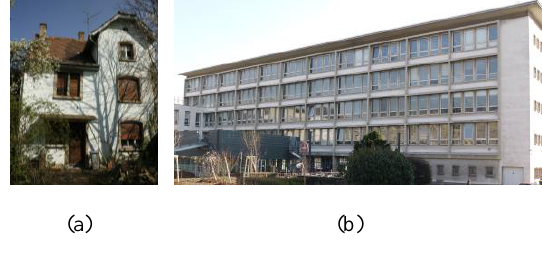
Figure 1. Buildings under study: